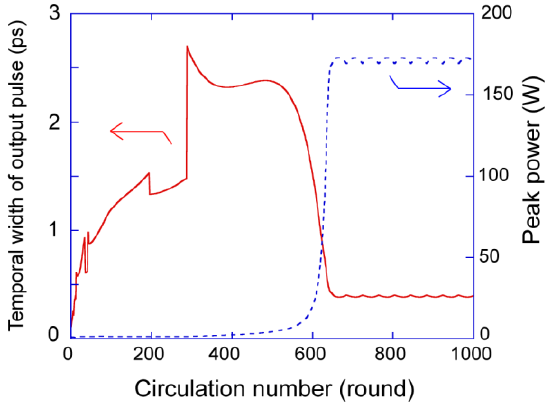
Figure 10. Variation of temporal width and peak power of output pulse for initial passive mode-locking process in dissipative soliton mode-locking condition ( D T = +0.02 ps 2